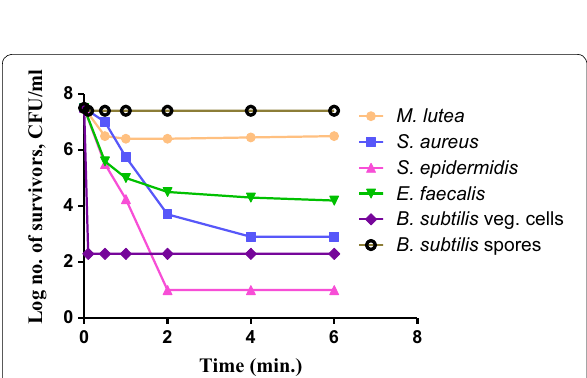
Pseudomonas aeruginosa was the least sensitive organ- ism, as shown by the results obtained by all the used tests, while A. niger was completely insensitive as shown by the broth dilution and agar diffusion methods. On the other side, study of the biocidal activity of OV EO emulsion using viable count technique showed that 75% of C. albi- cans colonies died at a concentration of 0.09% v/v of the